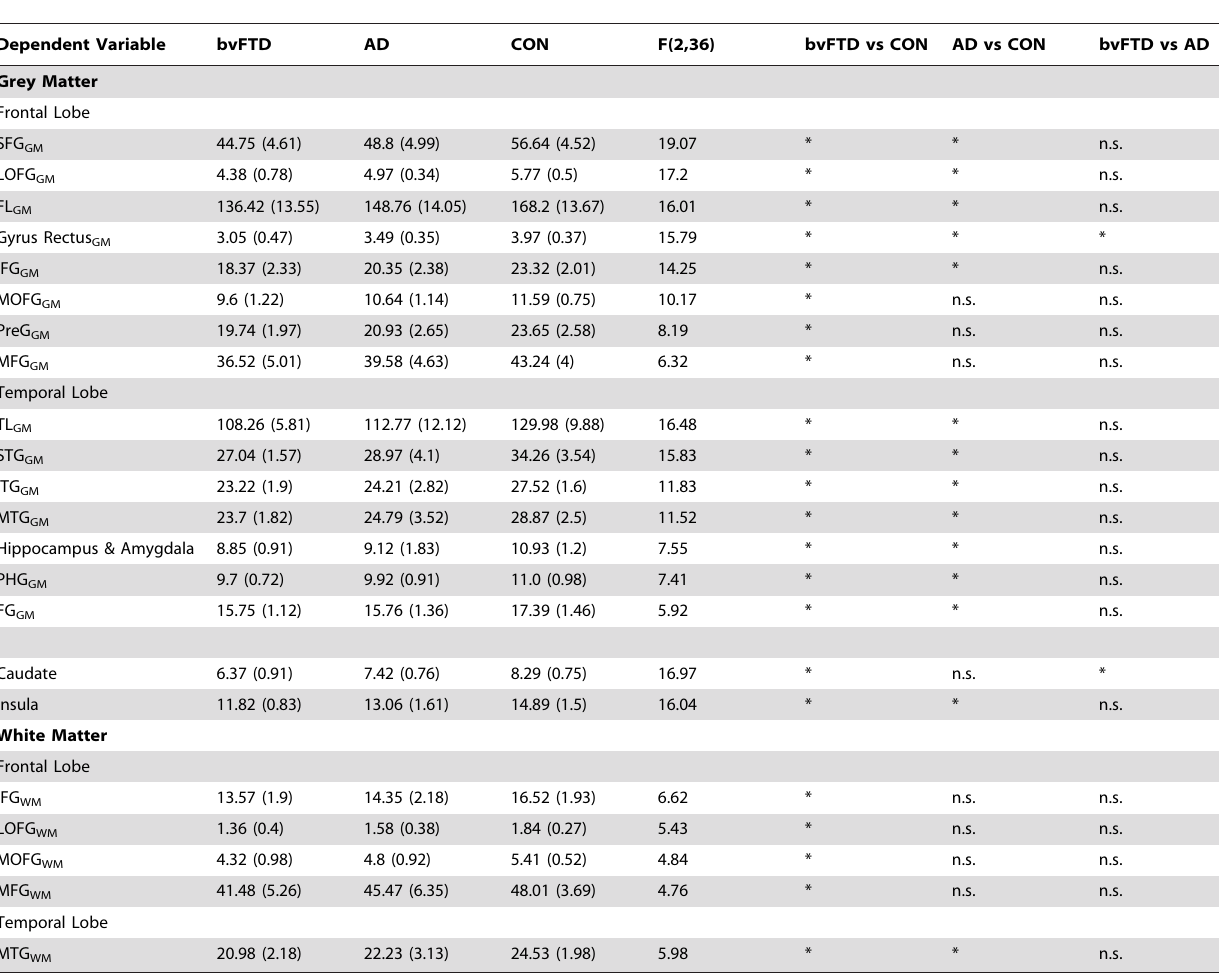
Table 3. Anatomical structures that showed significant group differences of volumes at clinic presentation (FDR-corrected p0.05). Per group mean and S.D. (in ml), univariate between-subjects effects, and pairwise post-hoc Bonferroni test